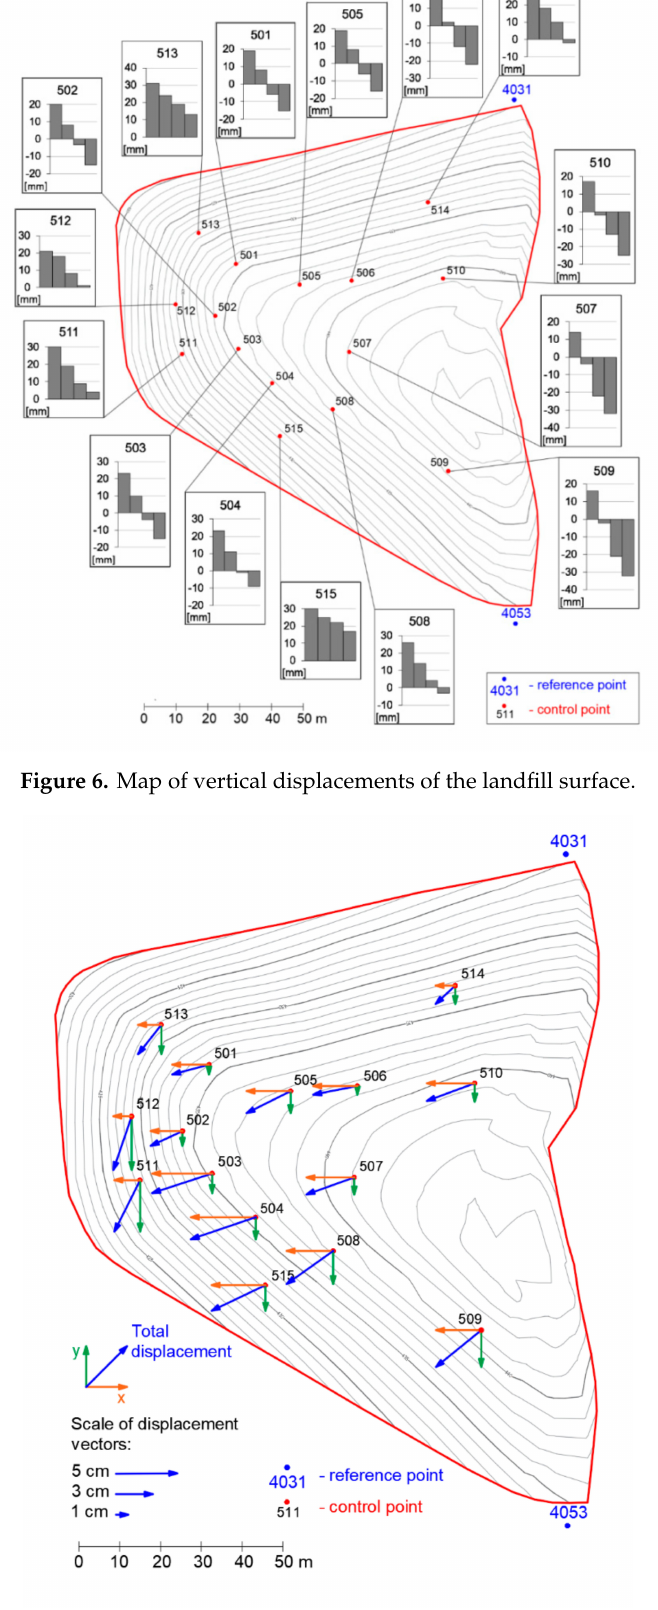
Figure 7. Map of horizontal displacements of the control points on the landfill